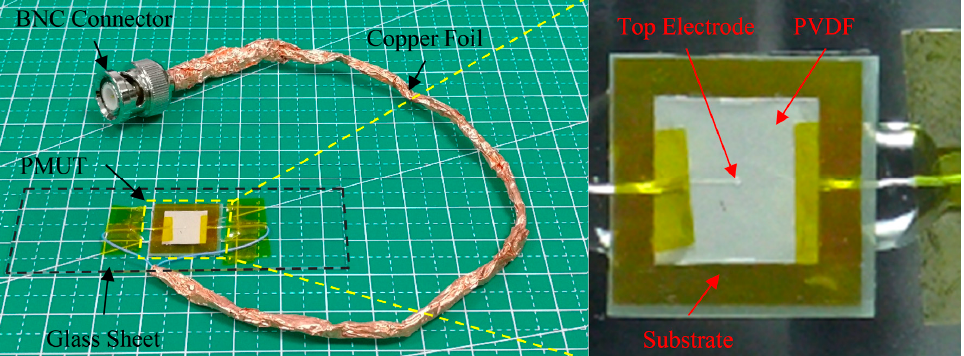
Figure 12. The optical image of PMUT mounted on a glass sheet.